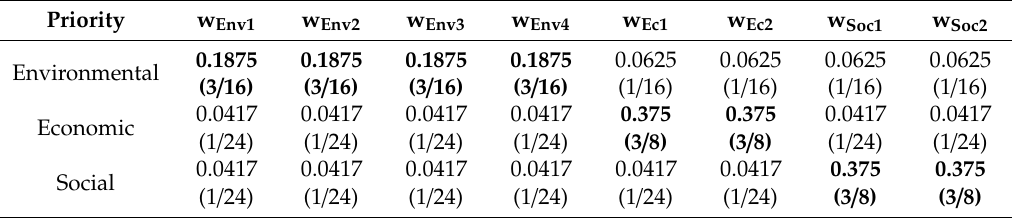
Table 5. Weight vectors emphasising each sustainability dimension with 75% of the weight. Priority w Env1 w Env2 w Env3 w Env4 w